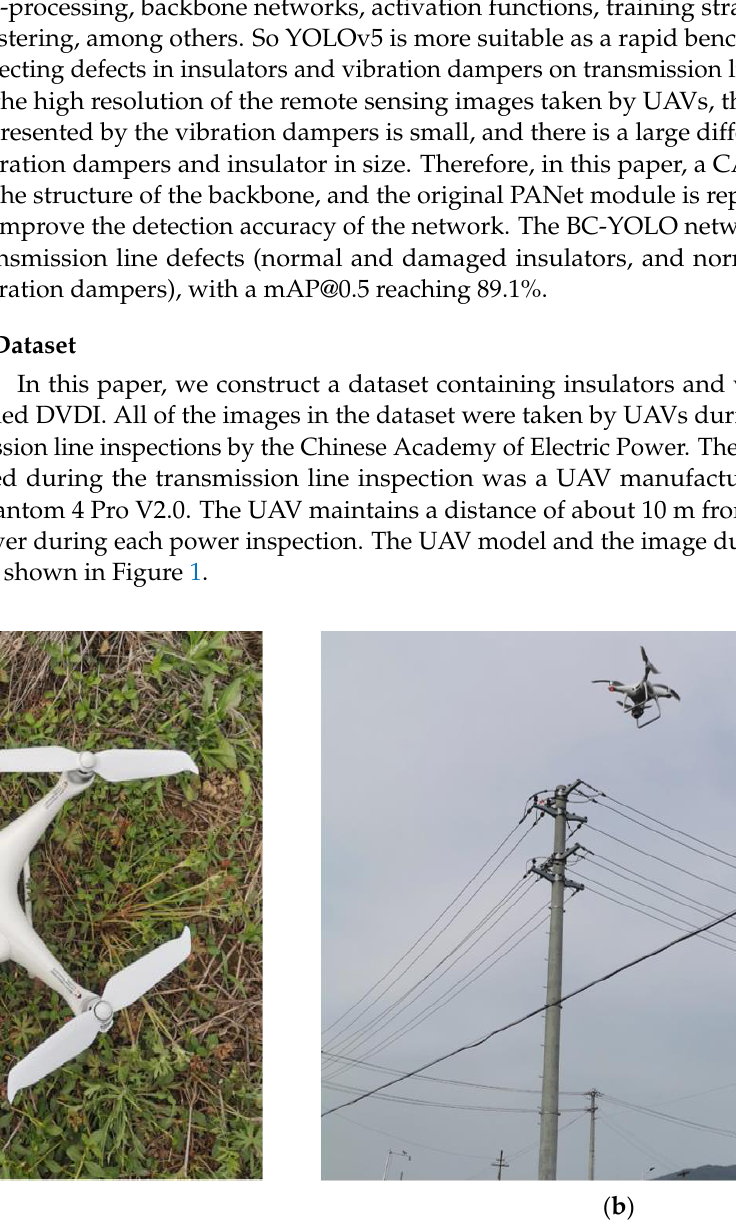
Figure 1. ( a ) Phantom 4 Pro V2.0 UAV; ( b ) UAV inspection shooting